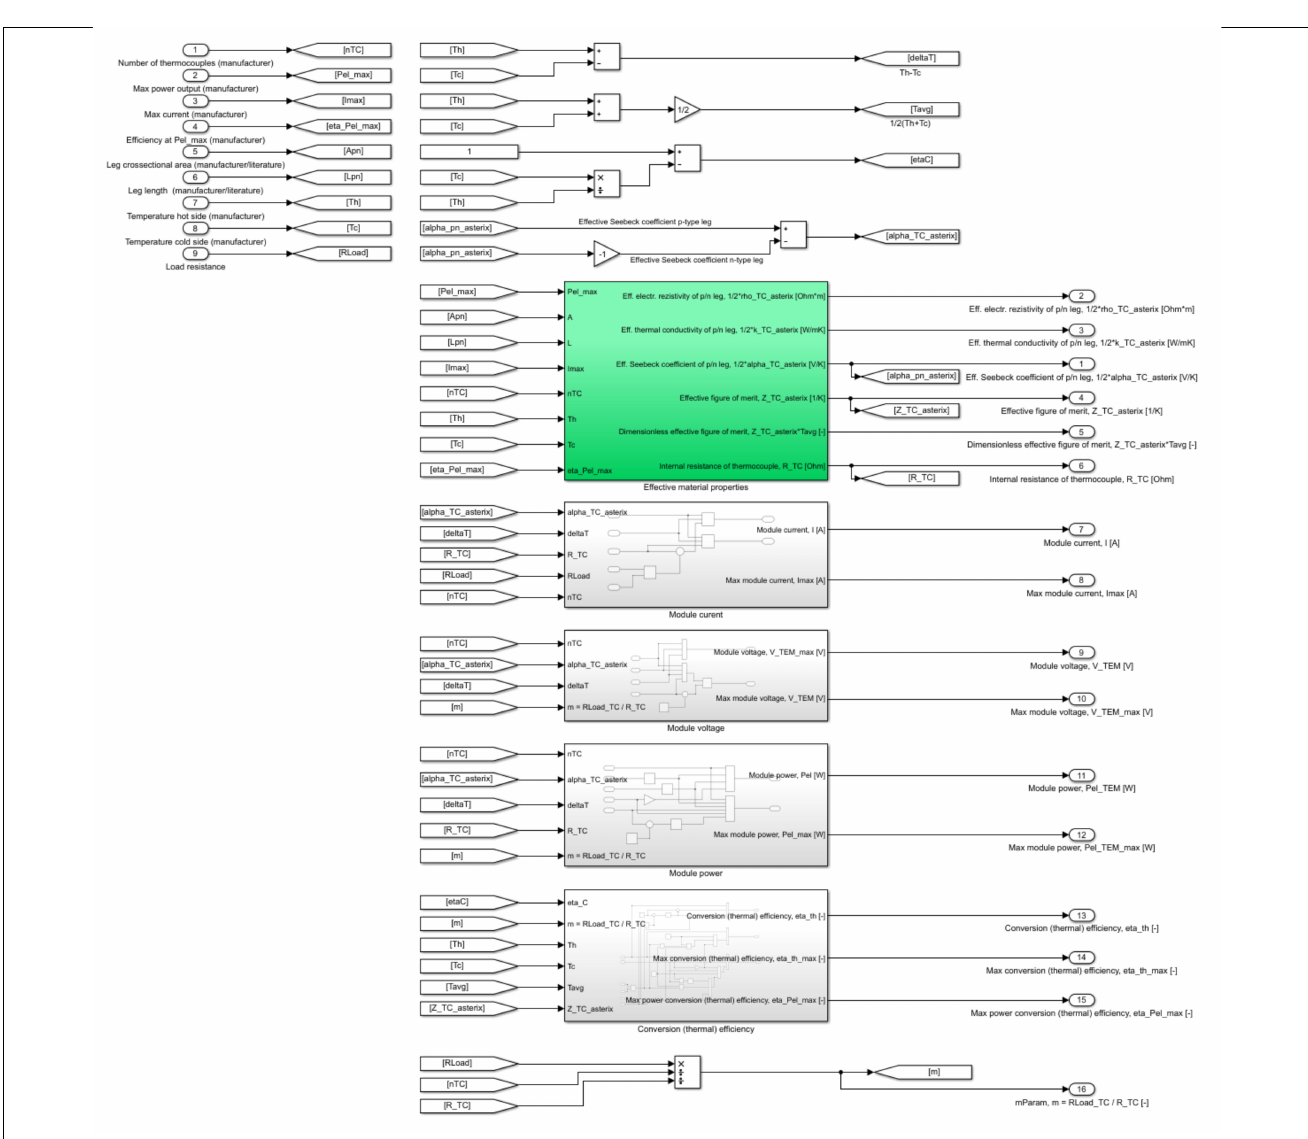
Figure A13. Effective properties model blocks (Figure 3)—equations.